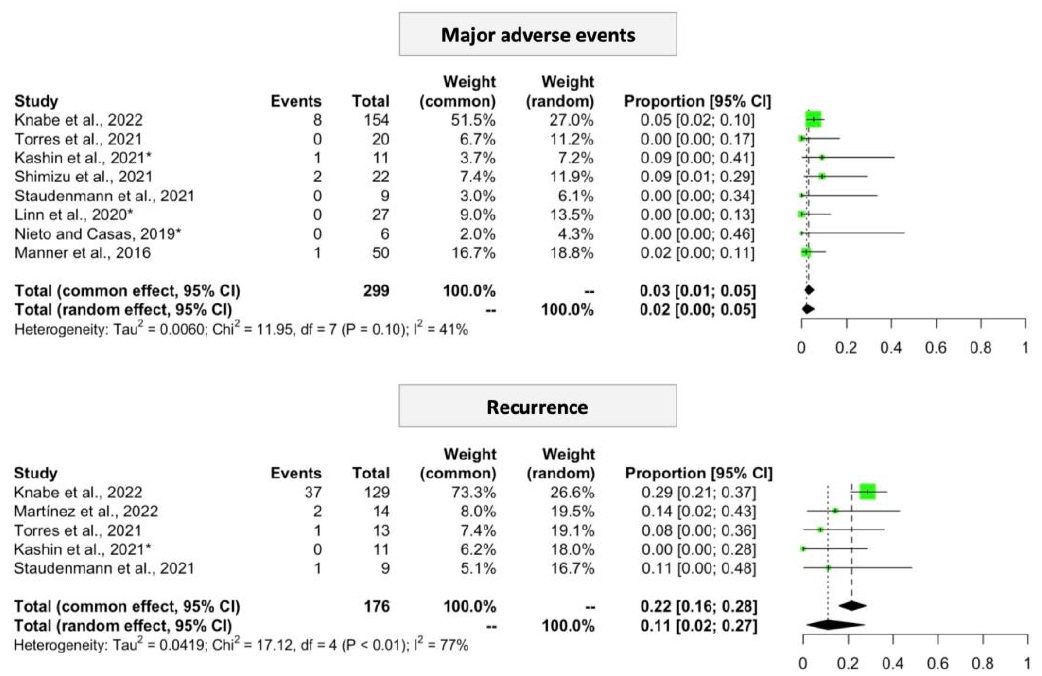
Figure 3. Proportions of adverse events and recurrence after hybrid argon plasma coagulation (hAPC) for Barrett’s esophagus (BE) ablation. Events = number of patients presenting major adverse events or recurrence; total = number of patients evaluated in which study. *Study available only in the